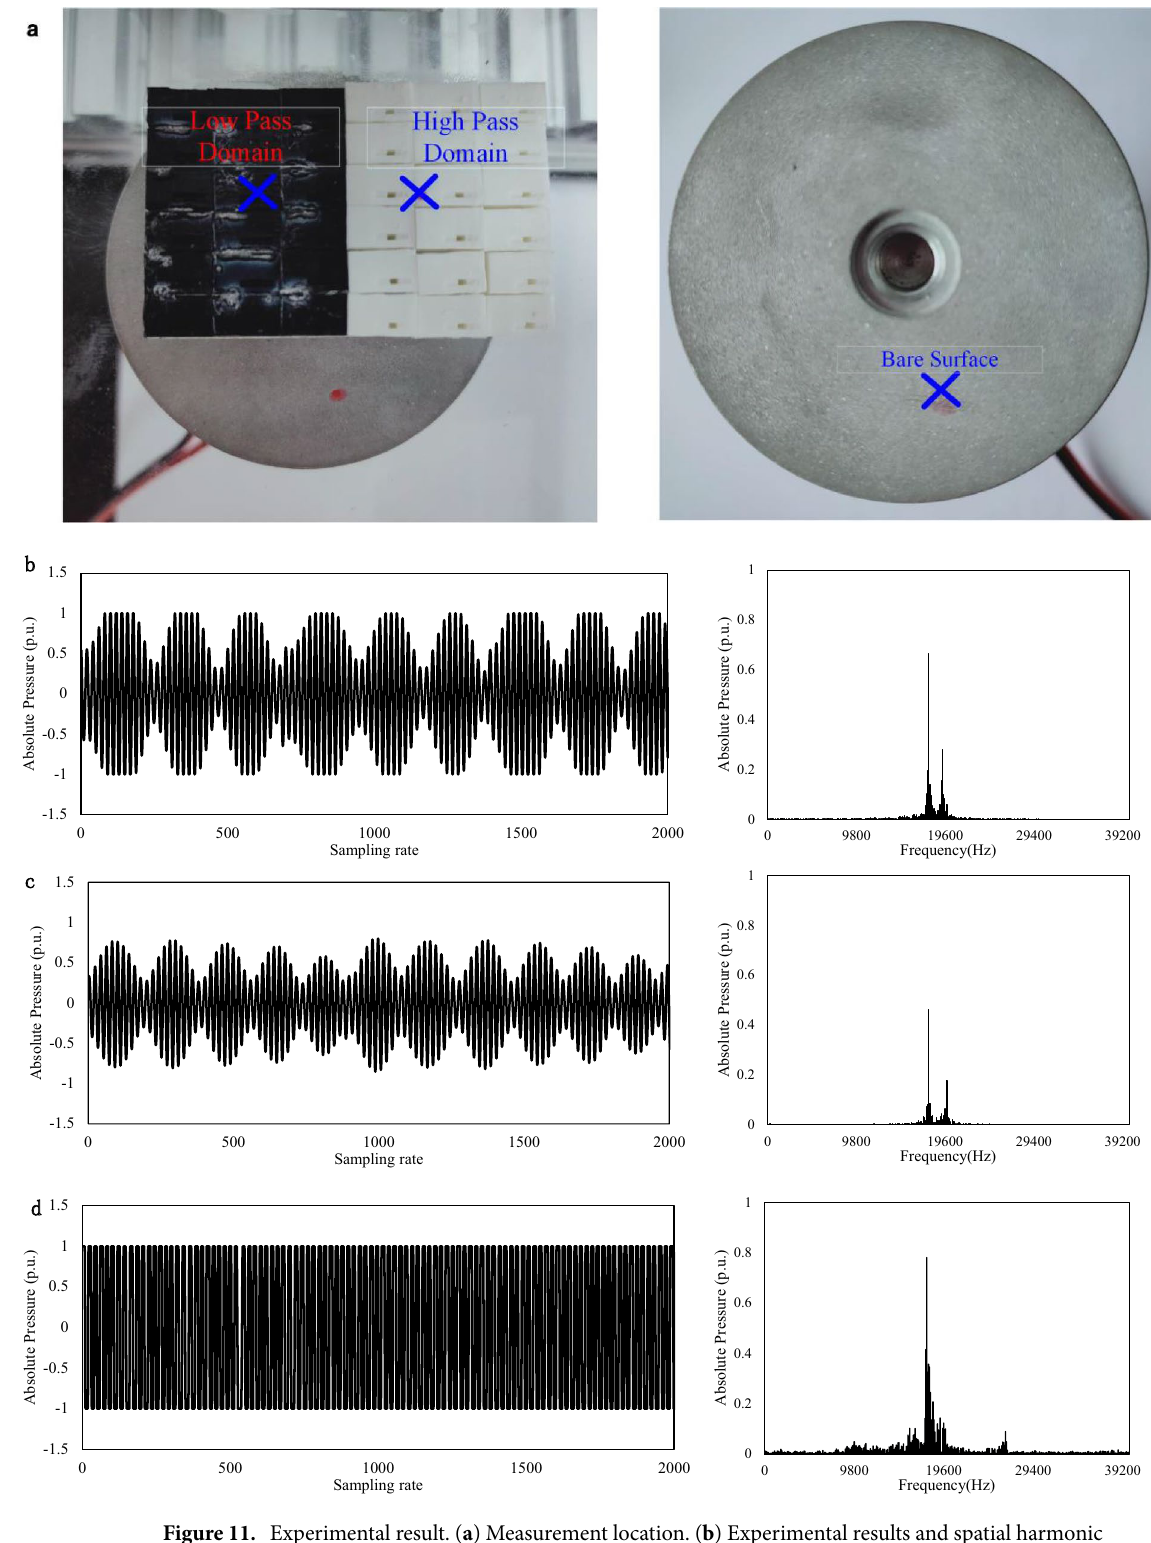
Figure 11. Experimental result. ( a ) Measurement location. ( b ) Experimental results and spatial harmonic distribution in high pass. ( c ) Experimental results and spatial harmonic distribution in low pass. ( d ) Experimental results and spatial harmonic distribution in high pass without